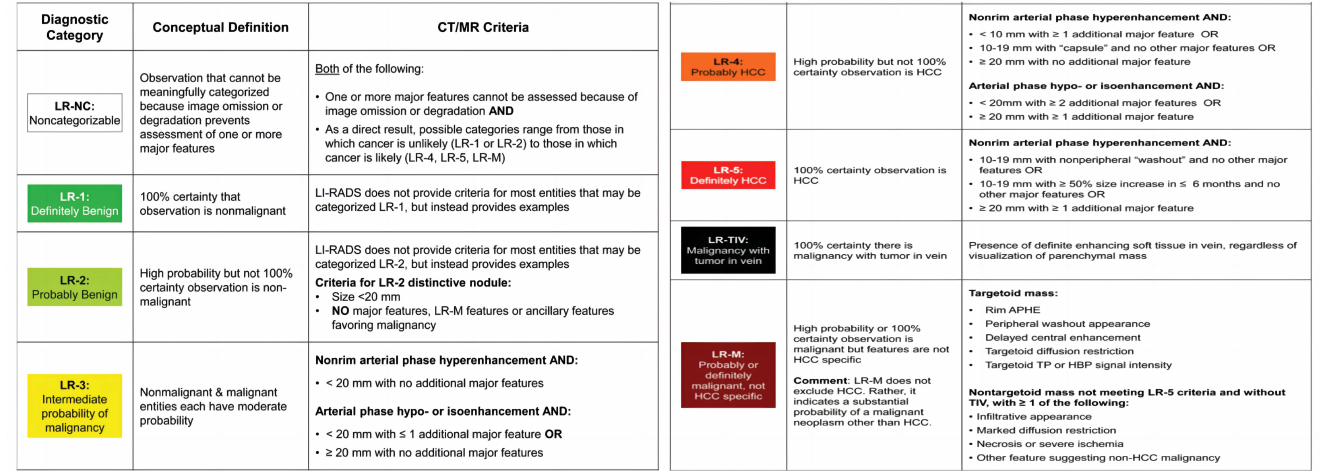
Figure 2. Summary of CT and MRI diagnostic Liver Imaging Reporting and Data System (LI-RADS) categories. APHE = arterial phase hyperenhancement; HBP = hepatobiliary phase; HCC = hepatocel- lular carcinoma; TIV = tumor in vein; TP = transitional phase